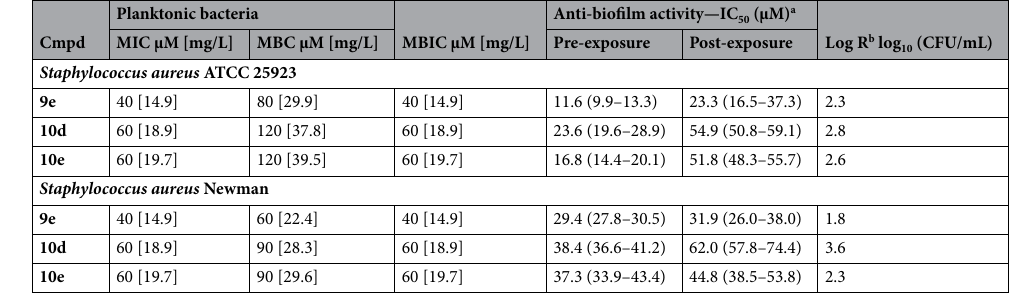
Table 2. Antibacterial and anti-biofilm activity of the most active compounds against S. aureus ATCC 25923 and S. aureus Newman strains. a The 95% confidence interval are shown in parentheses. b Logarithm of reduction of biofilm burden on a pregrown biofilm. Compounds were tested at 100 µM.